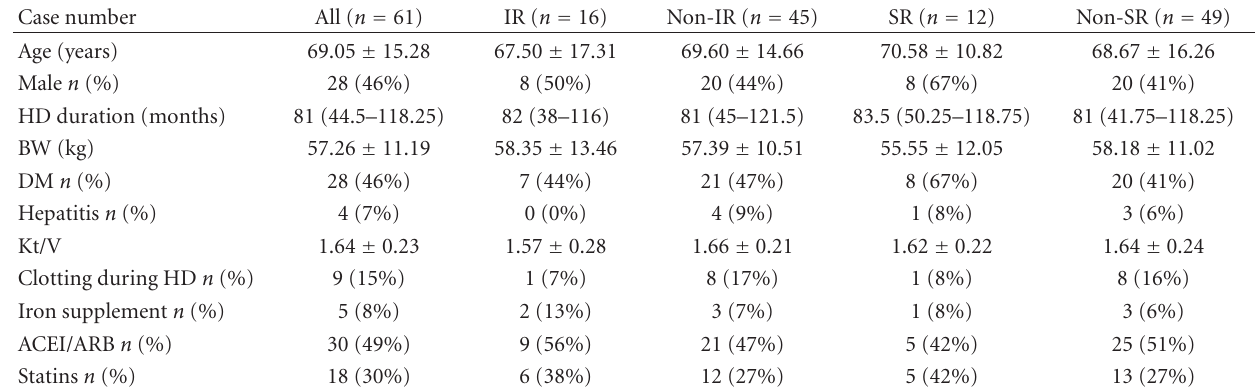
Table 1: Comparison of the baseline demographic and clinical parameters among all study patients, initial responders (IR), the rest of the study patients (Non-IR), sustained responders (SR), and the rest of the study patients (Non-SR) after treatment of CERA.